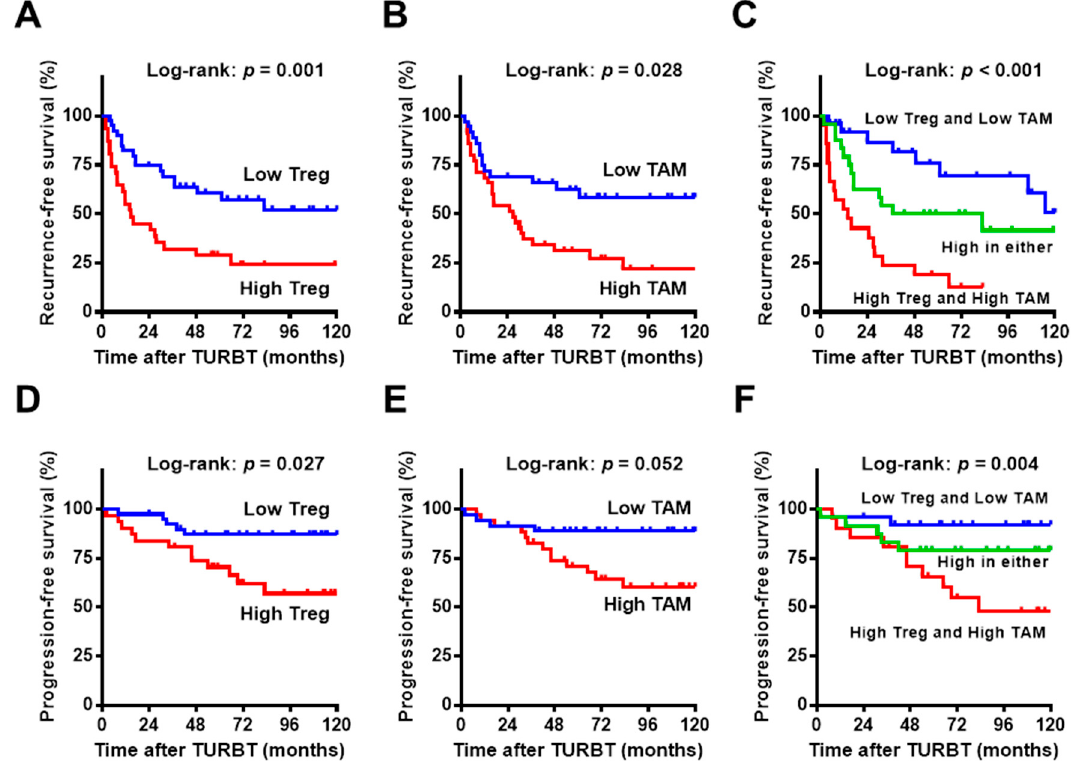
Figure 2. Kaplan–Meier plots for 71 patients treated with intravesical BCG. Intravesical recurrence-free survival ( A – C ) and progression-free survival ( D – F ) after initial TURBT are plotted. ( A , D ) Survival curves according to the Treg count, low (<10 cells/HPF) vs. high ( ≥ 10 cells/HPF); ( B , E ) survival curves according to the TAM count, low (<25 cells/HPF) vs. high ( ≥ 25 cells/HPF); ( C , F ) survival curves according to the number of immune cells with high counts (0, blue; 1, green; 2, red). The log-rank test was used for comparison. Treg, regulatory T cell; TAM, tumor-associated